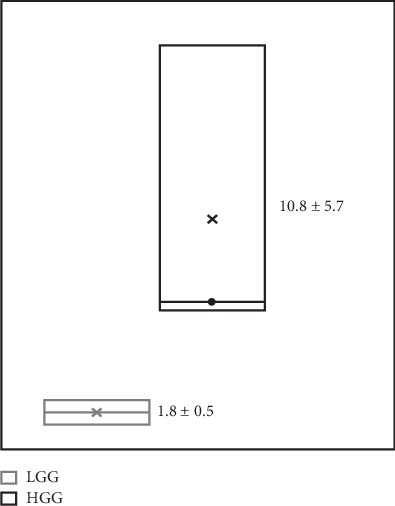
Correlation of the tumor/background uptake ratios (T/Bmax), evaluated by SPECT (99mTc CXCR4-L), and the WHO pathological grade: high-grade gliomas (HGG) III-IV and low-grade gliomas (LGG) I-II (Spearman rs = 0.94, p < 0.003).